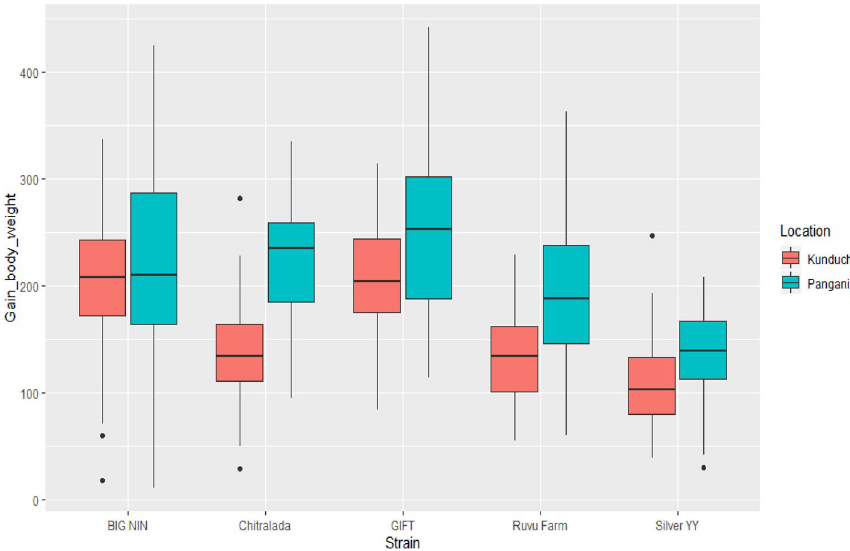
Figure 1. Box plots representing mean body weight gain of Nile tilapia strains reared at Kunduchi and